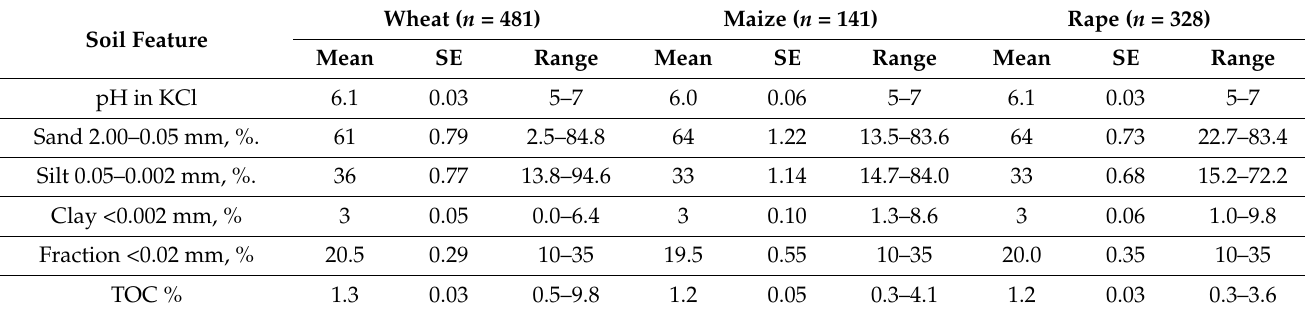
Table 4. Characteristic of soil